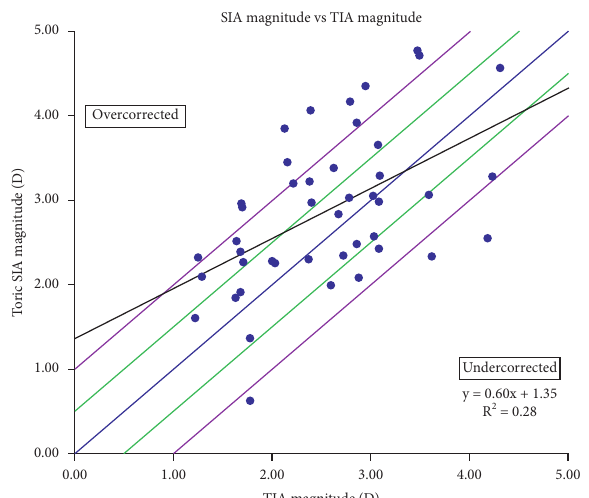
Figure 2: A plot of the surgically induced astigmatism (SIA) magnitude versus the target-induced astigmatism (TIA) magnitude, demonstrating a slight tendency for